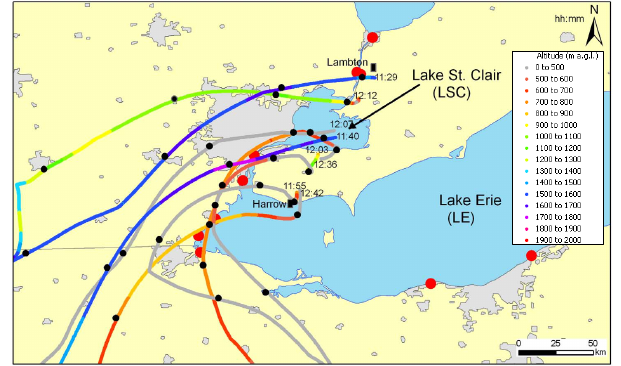
Fig. 2. High resolution back trajectories for 25 June arriving at selected locations and times along the Flight 4 aircraft track. Arrival times indicated as hh:mm. Trajectories are coloured by altitude (m a.g.l.). Black circles along trajectories every 4h . SO 2 point sources shown as red circles (SO 2 > 10000